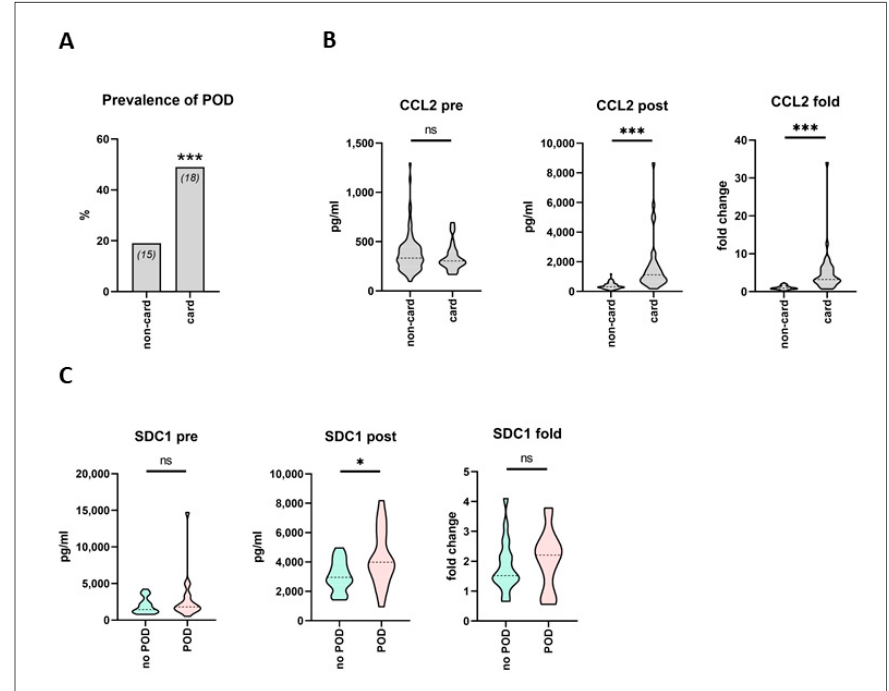
Figure 4. Pre- and postoperative serum biomarker profiling in cardiac and non-cardiac surgery patients. Serum was sampled prior to and following surgery from a mixed cohort of consecutively recruited elective non-cardiac as well as cardiac surgery patients. Biomarker profiling was performed using multiplex array technique. Development of postoperative delirium (POD) was assessed. ( A ) Prevalence of POD was significantly increased in cardiac surgery patients, as compared to non-cardiac surgery (18 out of 37 (49%) vs. 15 out of 81 patients (19%)). Fisher’s exact test. *** p < 0.005. ( B ) In cardiac surgery patients, CCL2 (CC-chemokine Ligand 2) showed a significant difference in postoperative absolute as well as fold-change increase, irrespective of POD development, as compared to the non-cardiac surgery patients. non-cardiac: n = 81, cardiac: n = 37. ( C ) In cardiac surgery patients, postoperative SDC1 (Syndecan-1) serum levels were significantly increased in patients that subsequently developed POD, as compared to the no-POD cardiac surgery patients. no POD: n = 19, POD: n = 18. ( B , C ) Data are given as median values (black dashed line) with 25th and 75th percentile (white dashed lines) and were compared using the Mann-Whitney U test. ns = not significant, * p < 0.05, *** p < 0.005.